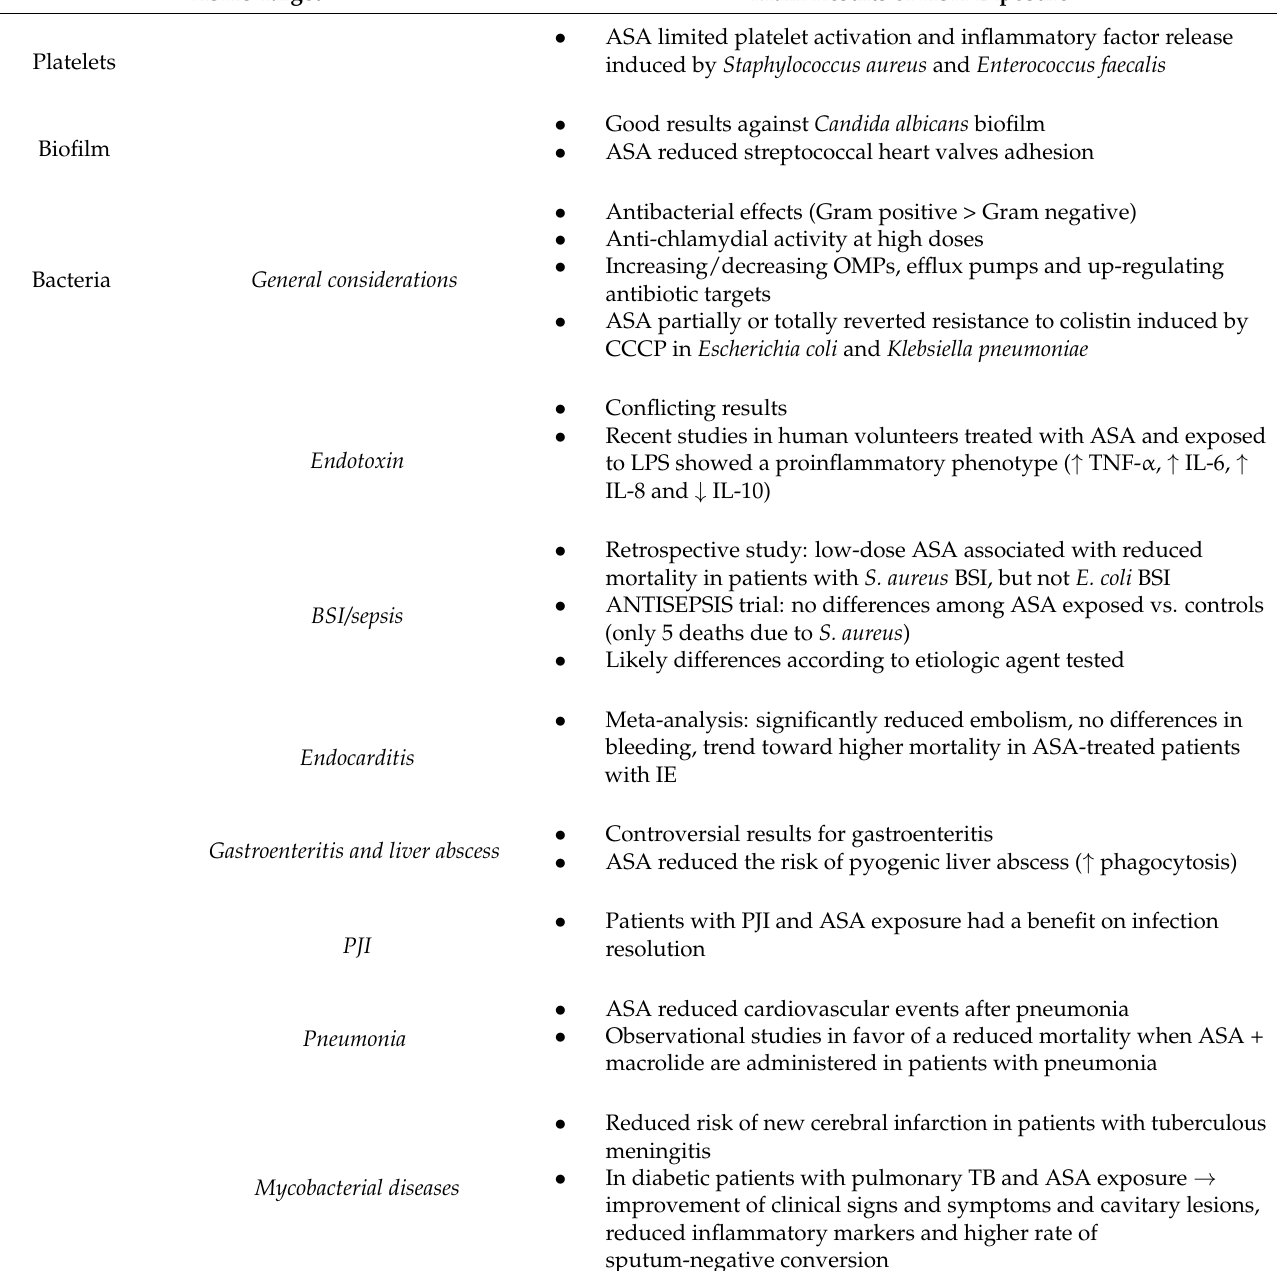
Table 1. Summary of the most relevant results of the literature review (see the main text for further details and specific